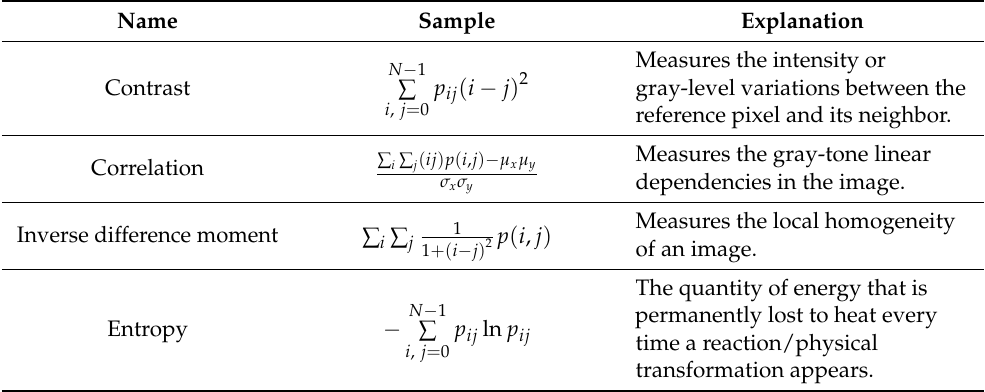
Table 3. Description and explanation for texture features extracted from the